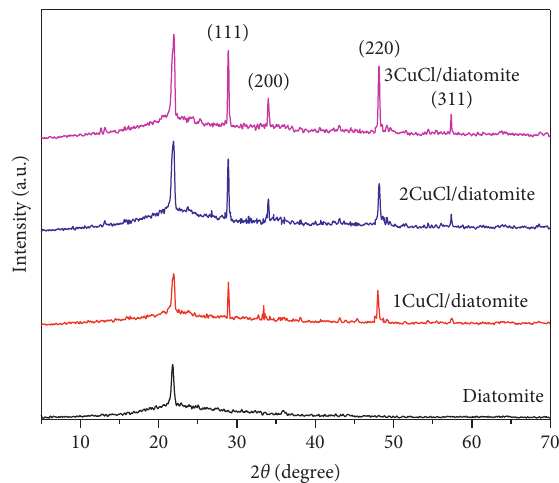
Figure 1: XRD patterns of diatomite and CuCl/diatomite samples.